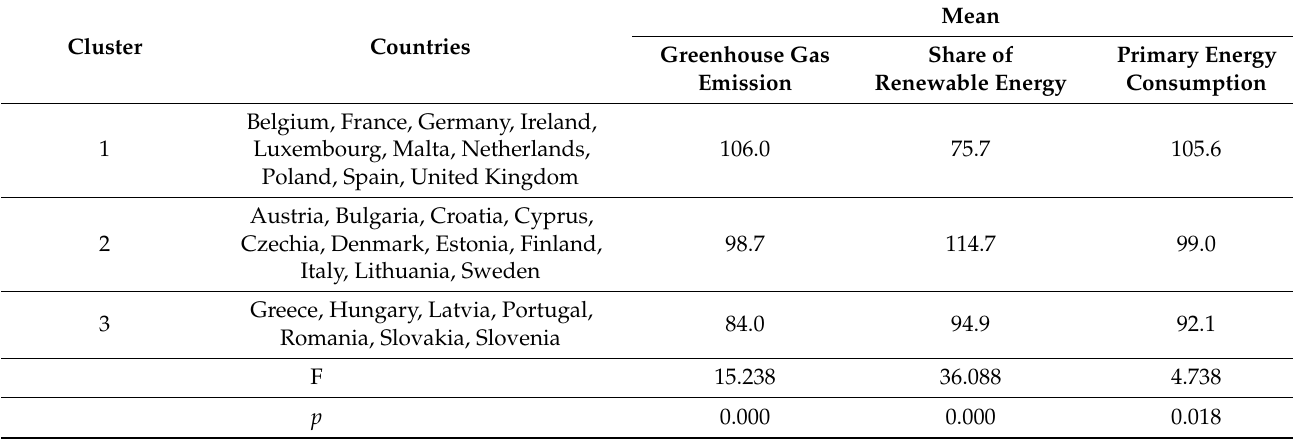
Table 8. Results of k-means clustering in